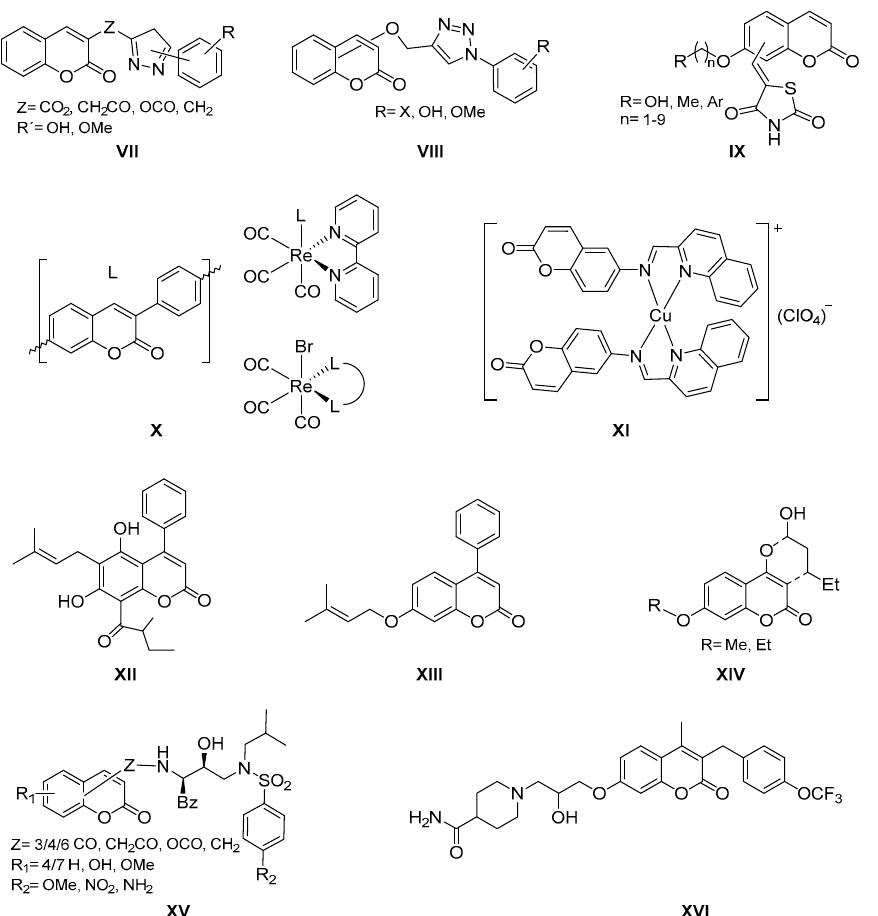
Figure 3. Structures of coumarin derivatives as antimicrobial agents.